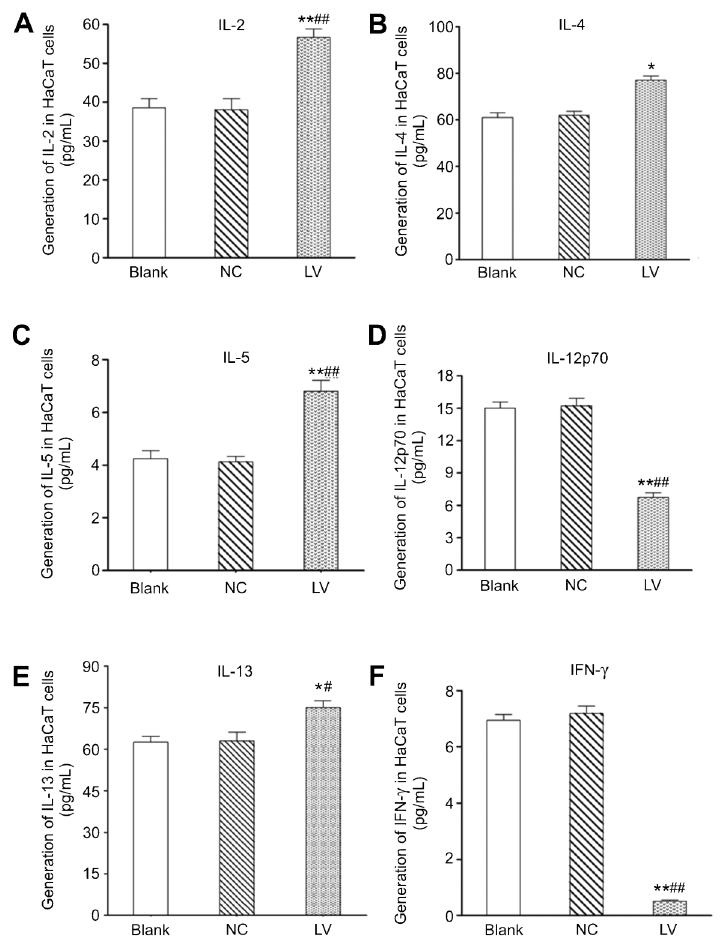
Figure 3. Influence of filaggrin silencing on cytokine generation in normal human epidermal keratinocytes (NHEKs). LV group: filaggrin- silenced cells; NC group: shRNA control cells; Blank group: noninfected cells. *P , 0.05, **P , 0.01 vs Blank group; # P , 0.05, ## P , 0.01 vs NC group (least significant difference